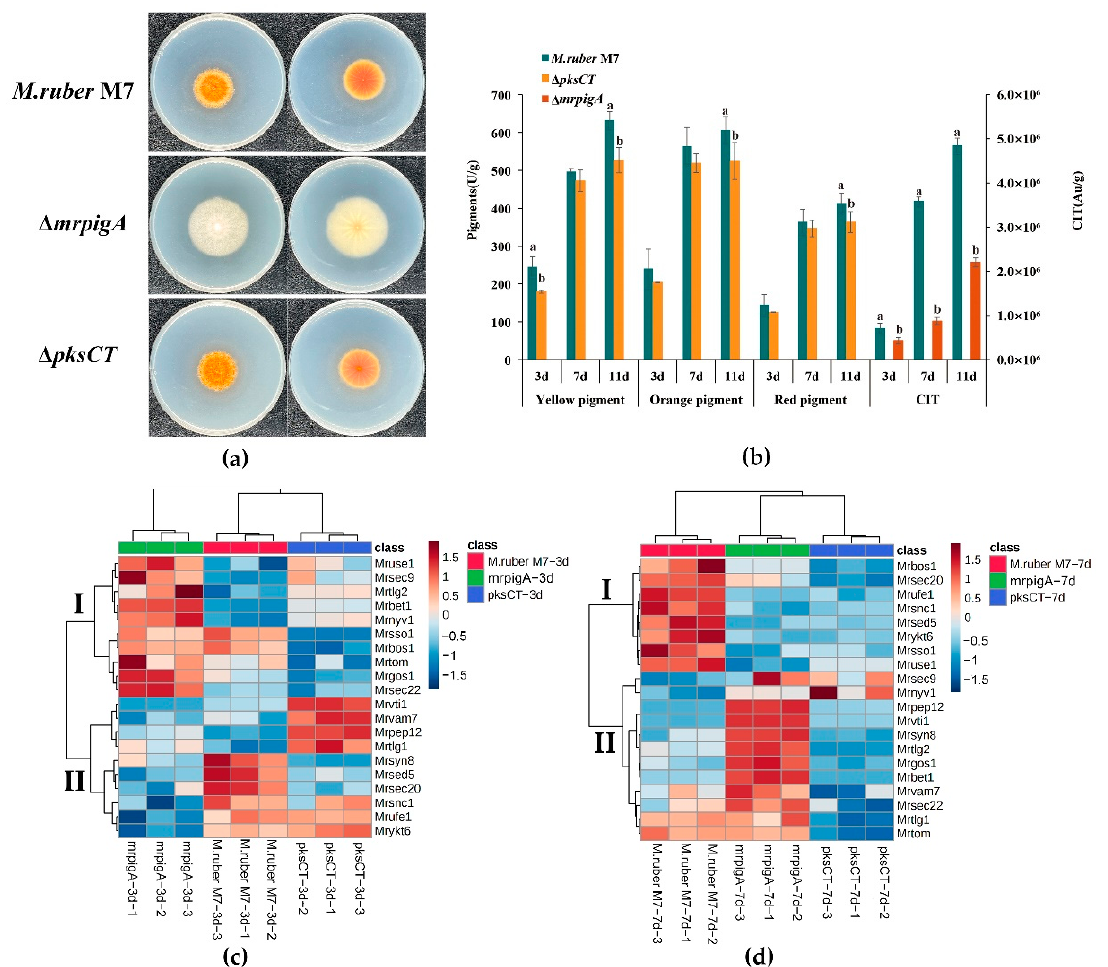
Figure 6. Analysis of potential SNARE genes involved in MPs and CIT synthesis. ( a ) Colony morphology of M. ruber M7, Δ mrpigA and Δ pksCT on PDA plate after cultivating at 28 °C for 7 days. ( b ) MPs and CIT produced by M. ruber M7, Δ mrpigA and Δ pksCT . Different lowercase letters indicate the gene expression level is significantly different ( p < 0.05). ( c ) Heatmap based on relative expression levels of MrSNAREs on the 3rd day; the expression level of M. ruber M7-3d-1 is the control. ( d ) Heatmap based on the relative expression levels of MrSNAREs on the 7th day; the expression level of M. ruber M7-7d-1 is the control.